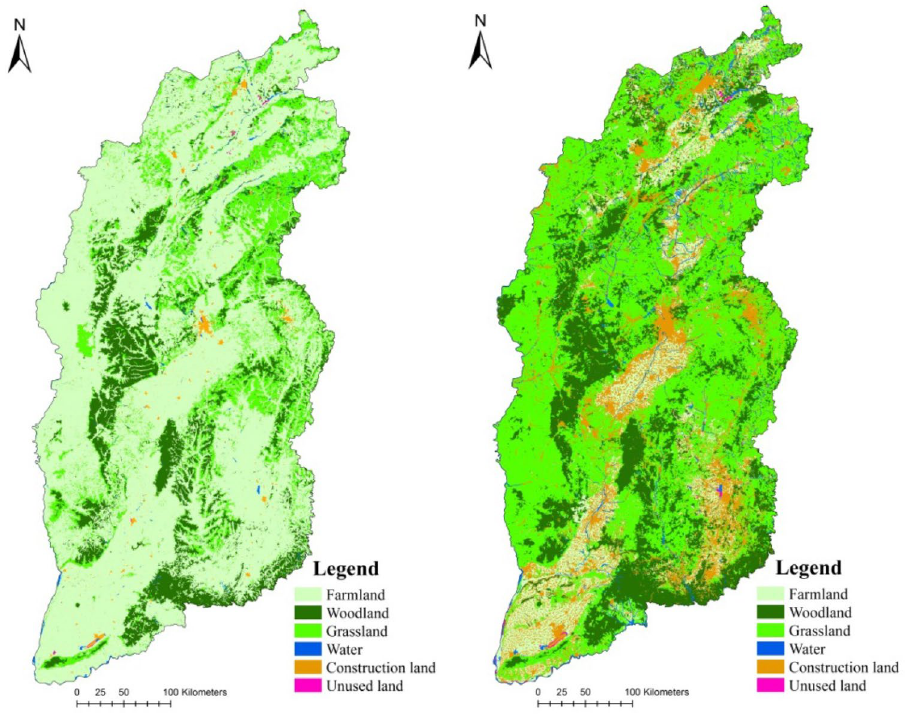
Figure 3. The land use and land cover data in 2000 and